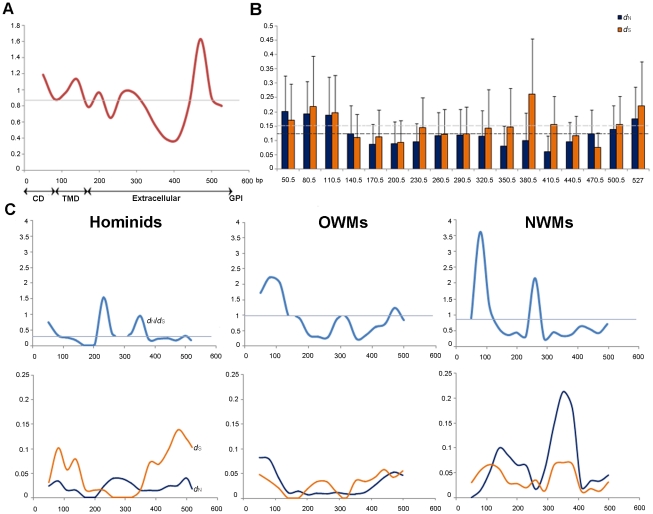
Sliding-window analyses of average d
N and d
S among the primate Tetherin sequences.
A. Sliding window d
N/d
S test among 17 primate Tetherin sequences. Numbers on the x-axis represent the sequence positions followed below by the domain map of Tetherin. B. Sliding-window analysis of average d
N and d
S among 17 primate Tetherin sequences. The middle position of each window on Tetherin is given on the X-axis. The bold and thin dashed lines show the average d
N and d
S for the entire sequences, respectively. The error bar shows one standard error. C. Upper panel: Sliding window d
N/d
S tests on three primate lineages (Hominids, OWMs and NWMs). The d
N/d
S value is not shown for part of the curve because d
S is zero in this region (see plot below). Lower panel: Sliding-window analyses of average d
N and d
S in three primate lineages. The sliding-window analyses were performed using a 100-bp sliding window moving in steps of 30-bp. The straight lines shown in A and C represent the average d
N/d
S ratios.